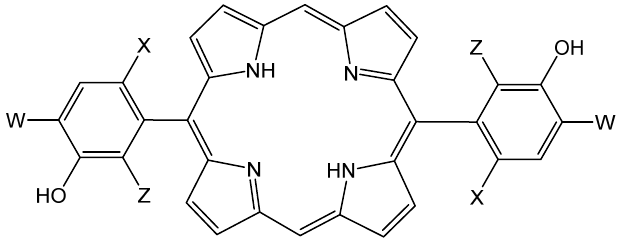
Figure 2. Structures of 5,15-diarylporphyrins used as PS1–5 [49].